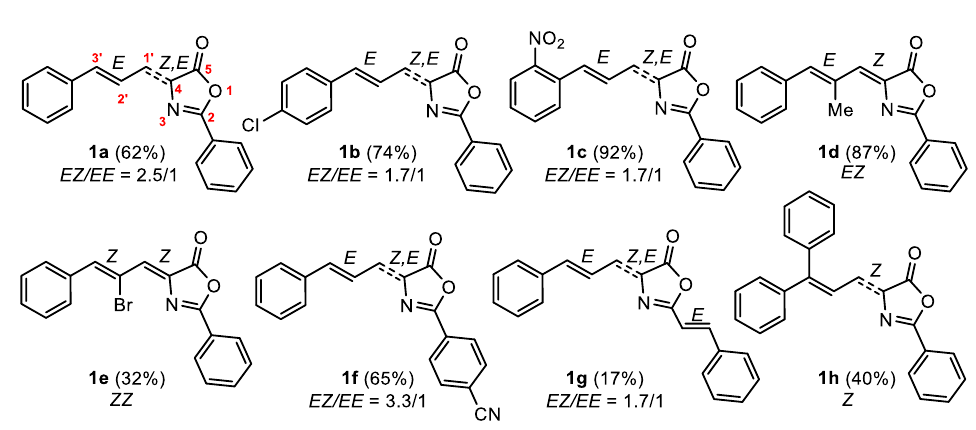
Figure 3. 2-aryl-4-( E -3′-aryl-allylidene)-5(4 H )-oxazolones 1a–1h prepared for this work.